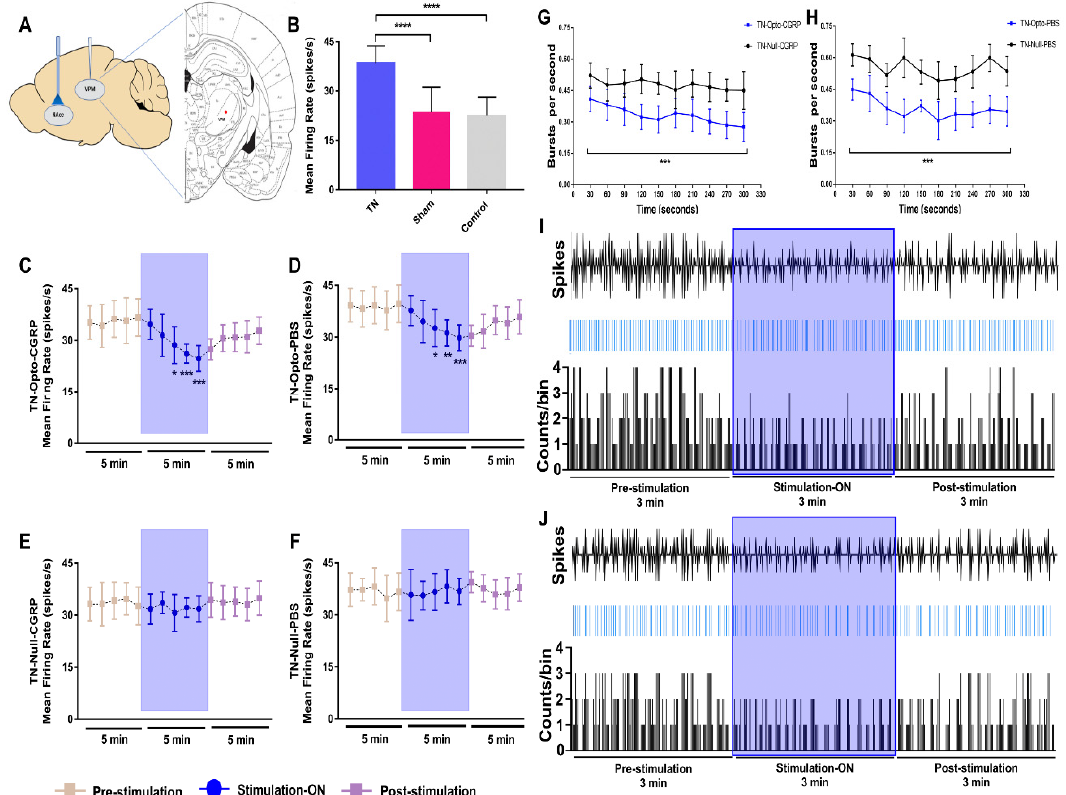
Figure 2. Extracellular recording data in vivo. ( A ) Schematic diagram showing extracellular recording area. ( B ) Evoked firing rates in VPM neurons in TN ( n = 32) animals versus sham ( n = 32) and control ( n = 4) animals (****, p < 0.0001, significant difference determined using unpaired t -tests). ( C , D ) In vivo recordings of the VPM thalamus from TN-Opto animals. ( C ) Findings for the TN-Opto-CGRP ( n = 8) group. ( D ) Findings for the TN-Opto-PBS ( n = 8) group. A decrease in firing output (spikes/s) was observed during the stimulation “ON” period. ( E , F ) No changes in the VPM thalamus firing rates were observed in the TN-Null-CGRP ( n = 8) or TN-Null-PBS ( n = 8) groups (two-way analysis of variance *, p < 0.05; **, p < 0.01; ***, p < 0.001). ( G , H ) Changes in the burst firing rates of the TN animals following optogenetic stimulation. A significant reduction was observed in the TN-Opto-CGRP ( G , blue line) and TN-Opto-PBS ( H , blue line) groups. ***, p < 0.001, analysis of variance. ( I , J ) Peri-event raster histogram of VPM neuron responses show spike traces (above), raster traces (middle), and rate histogram (below) in the TN-Opto-CGRP ( I ) and TN-Opto-PBS ( J ) groups in optic stimulation “ON and “OFF” states. Bin size = 50 ms. VPM thalamic responses were decreased during optic stimulation (blue area).